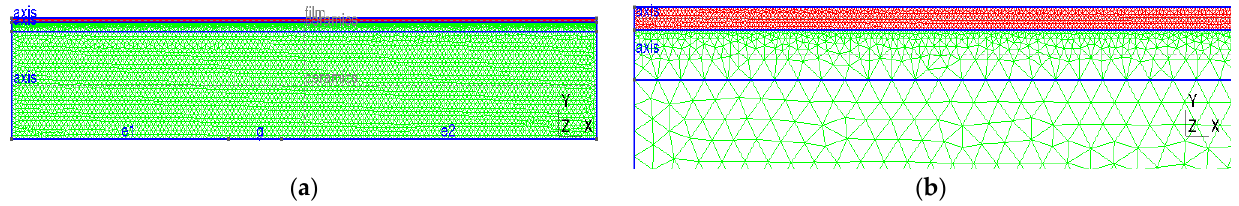
Figure 1. Finite element model of a resonator loaded with a viscoelastic conducting layer: ( a ) general view of the model; ( b ) enlarged view near the layer. Blue lines are the boundaries of the model, green the resonator, and red the layer.